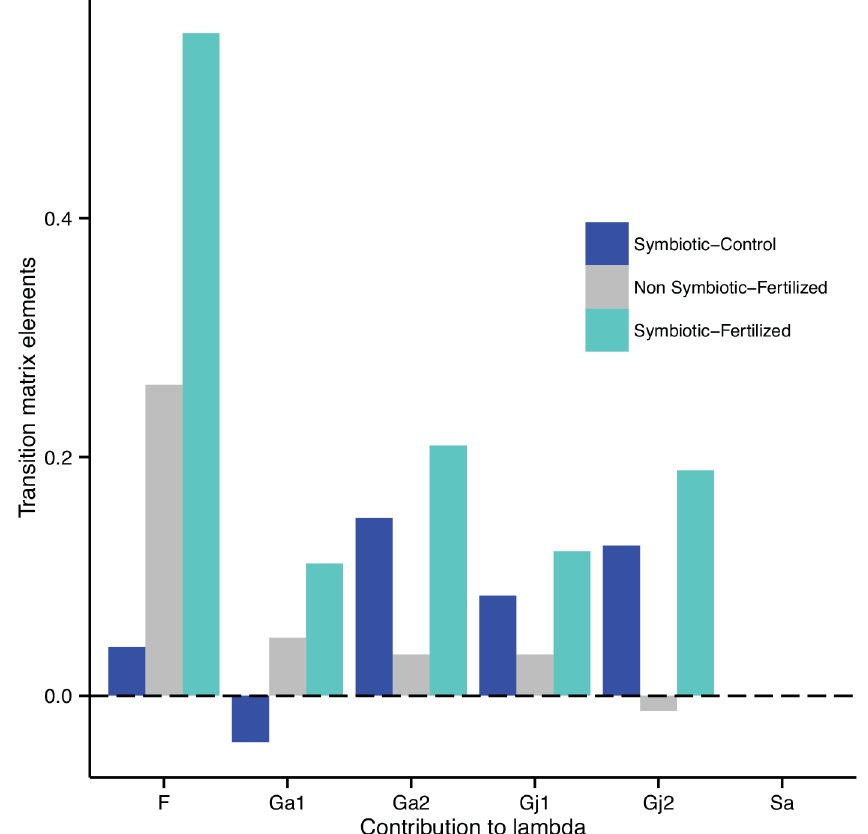
Fig 3. Contributions of matrix elements to the variability of λ for Festuca eskia populations, as a function of endophytic status and edaphic resource